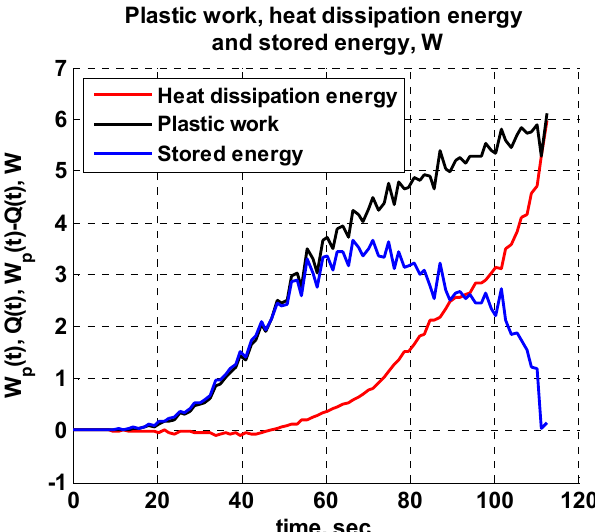
Figure 5: Time dependence of plastic work, heat dissipation energy and stored energy calculated for the smooth